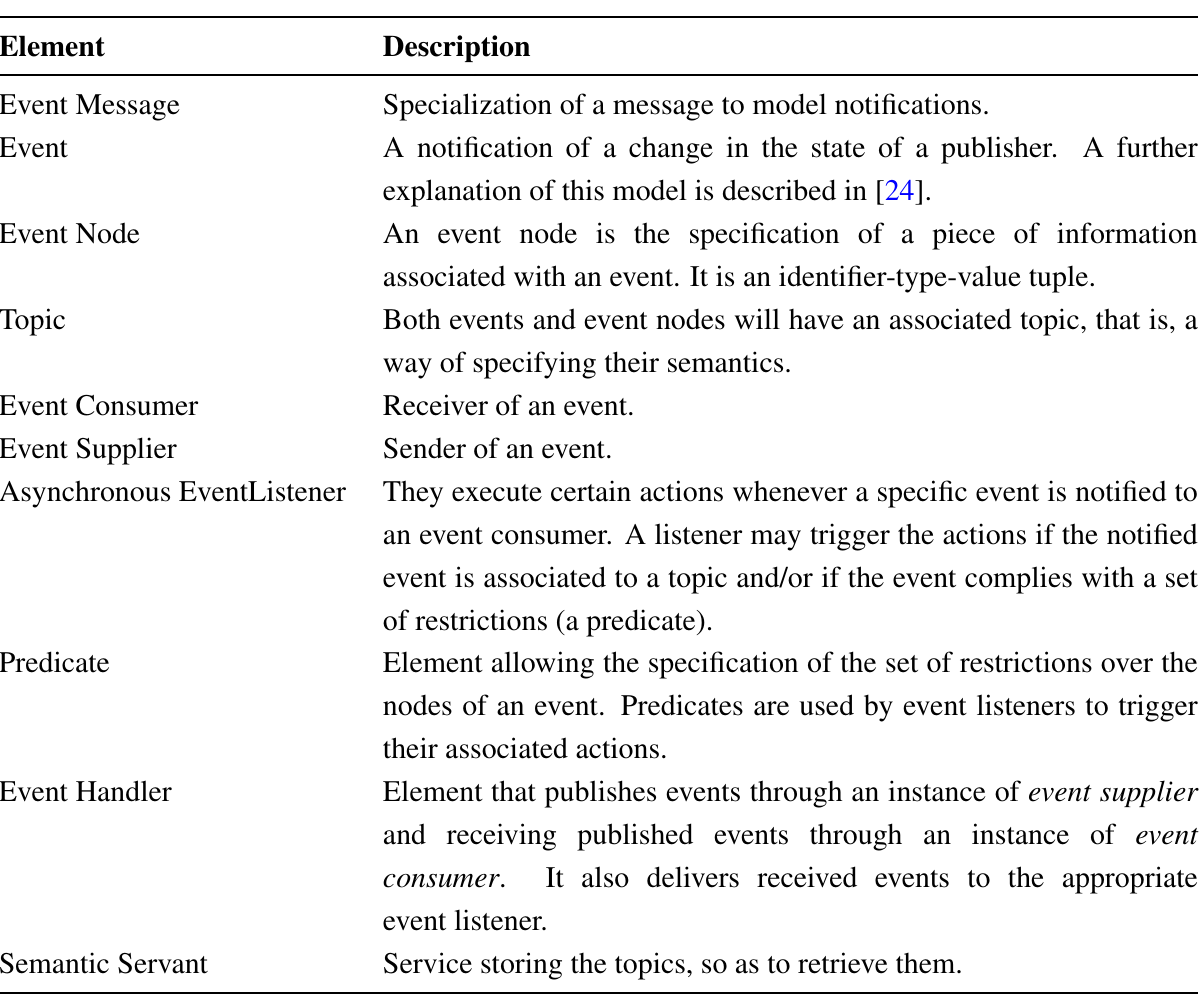
Table 4. Definition of the elements of the specialized model to support PubSub